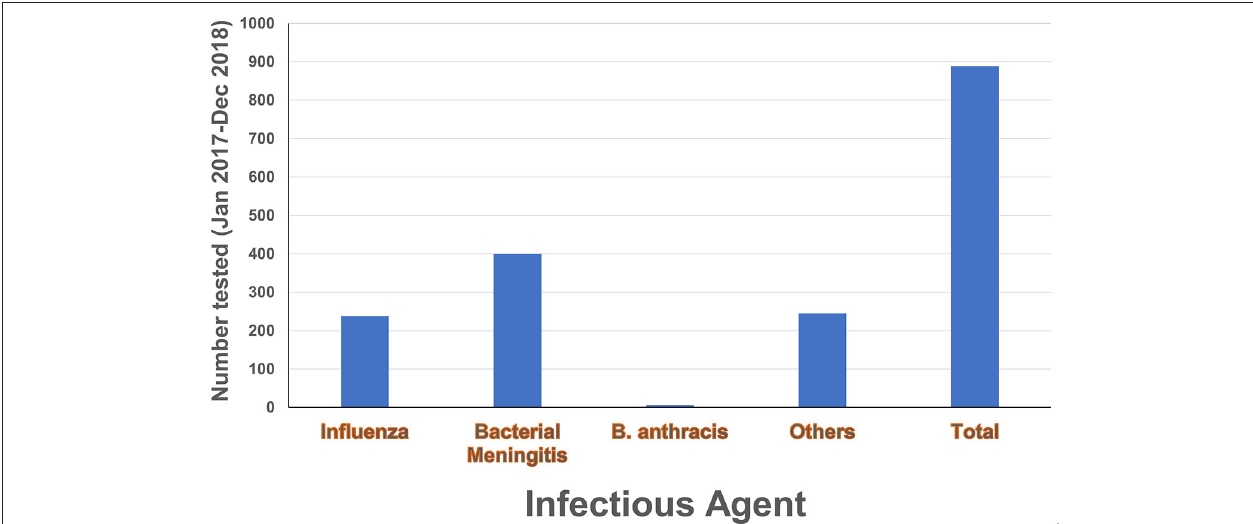
FIGURE 7 | Diagnostic testing activities. Number of tests conducted in the laboratory during 2017–2018 by local laboratory personnel under the mentorship of the country Program Lead. Diagnostic activities included anthrax testing, bacterial meningitis testing and sero-grouping, and influenza testing and subtyping. The category